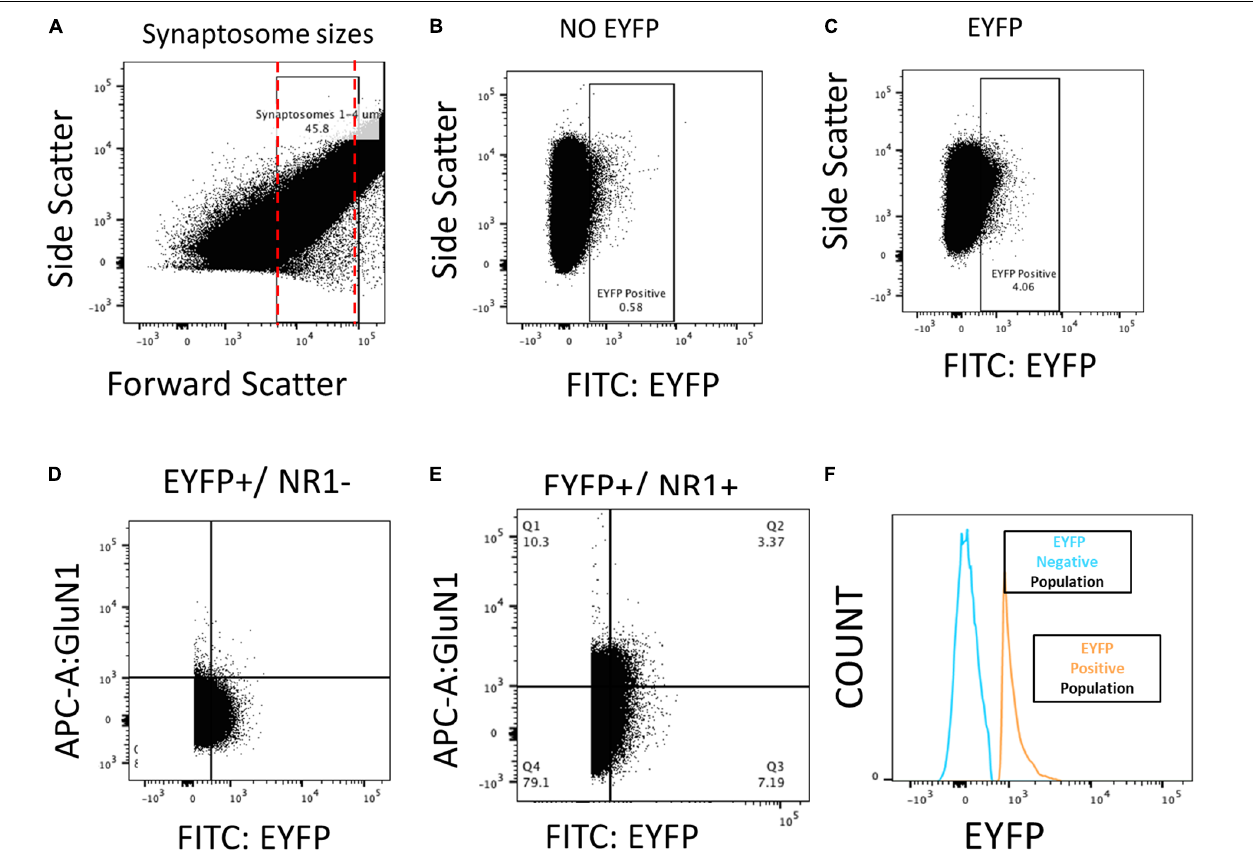
FIGURE 2 | FACS analysis of the NMDA subunit GluN1 on vHPC-to-IL synaptosomes from male and female rats. (A) Particles between 1 and 4 µ m were selected as synaptosomes after isolation from IL tissue and used for subsequent analysis. (B) Rats without virus (NO EYFP) had a low percentage of synaptosomes in the EYFP+ quadrant. (C) Rats injected with the EYFP-expressing virus into the VHPC showed abundant expression of EYFP+ synaptosomes isolated from IL tissue. (D) EYFP+/GluN1– samples that lacked the antibody against GluN1 show no expression in GluN1+ quadrants. (E,F) EYFP+/GluN1+ samples show abundant detection of EYFP+/GluN1+ synaptosomes, indicating that we could isolate and quantify GluN1 expression in VHPC-to-IL synaptosomes.